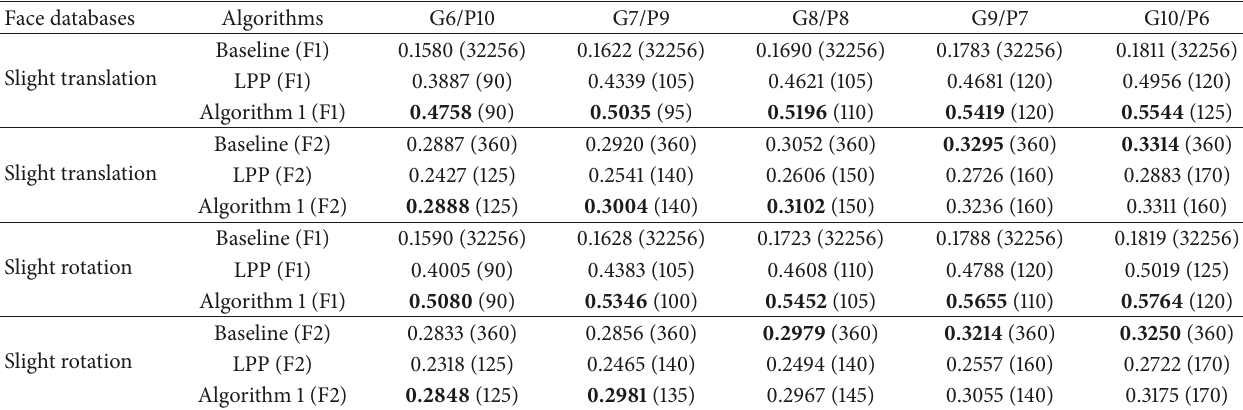
Table21:TherecognitionratesonslighttranslationandslightrotationExtendedYaleBfacedatabasesover“F1”and“F2”features;recognition rates (dimensionality).